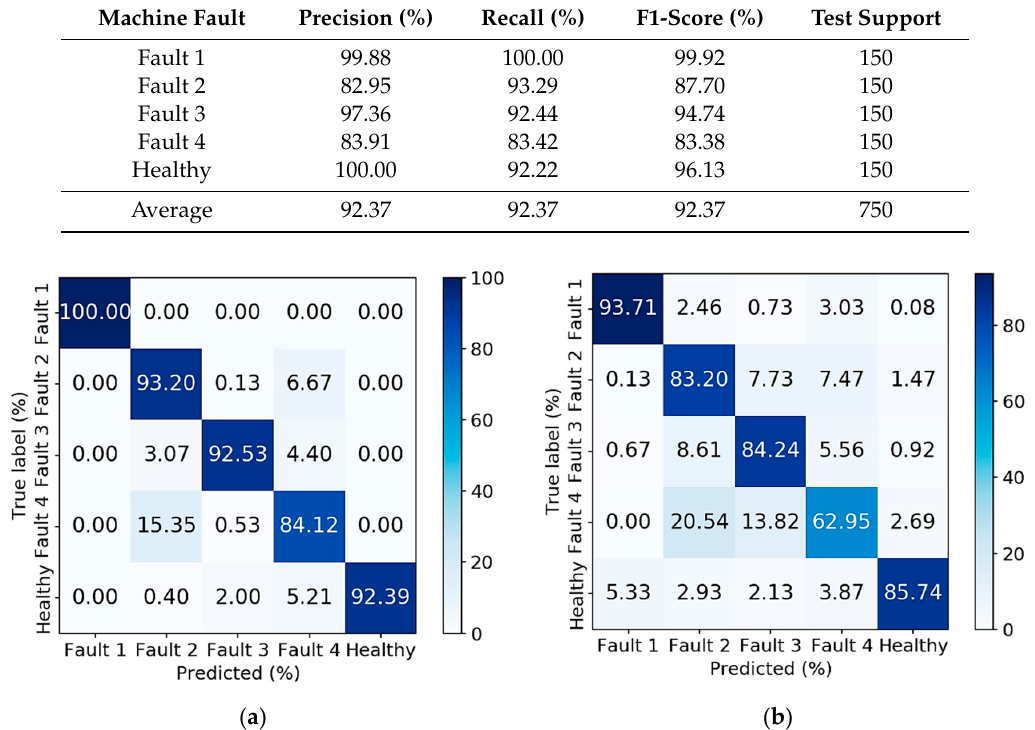
Figure 14. ( a ) Confusion matrix performance of FOP-CNN when motor load condition is used as an input label; and ( b ) confusion matrix performance when motor load condition is not used.